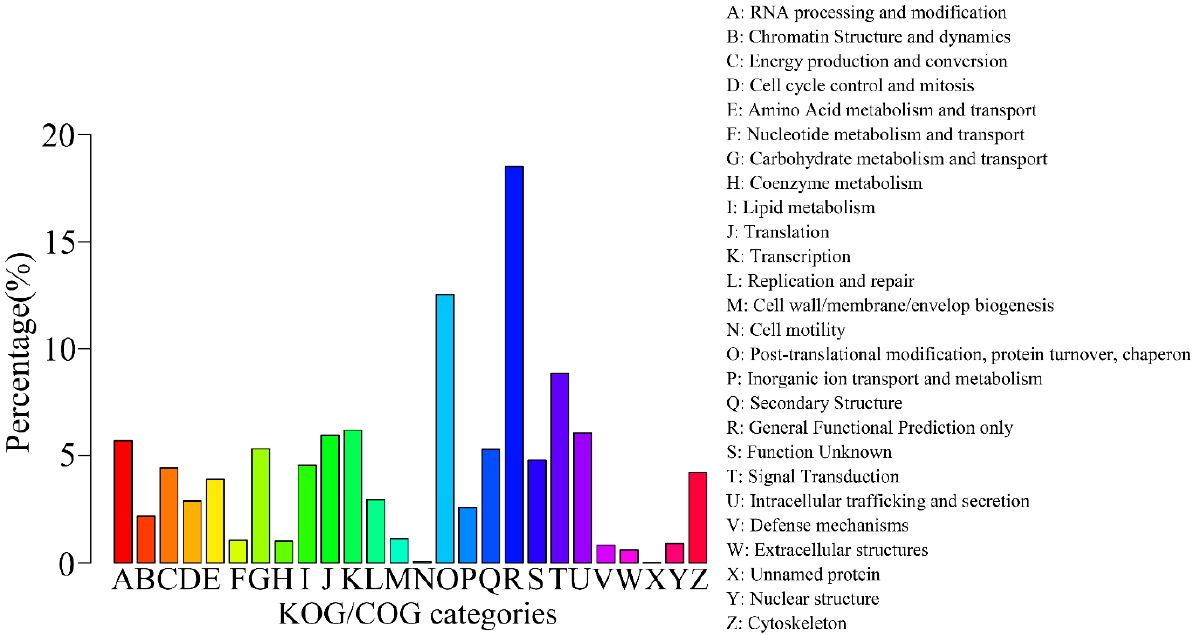
Figure 4. GO classification map. The abscissa represents the next level GO term of the three GO categories, while the ordinate represents the number of genes annotated into the corresponding term, and its proportion of the total number of annotated genes.